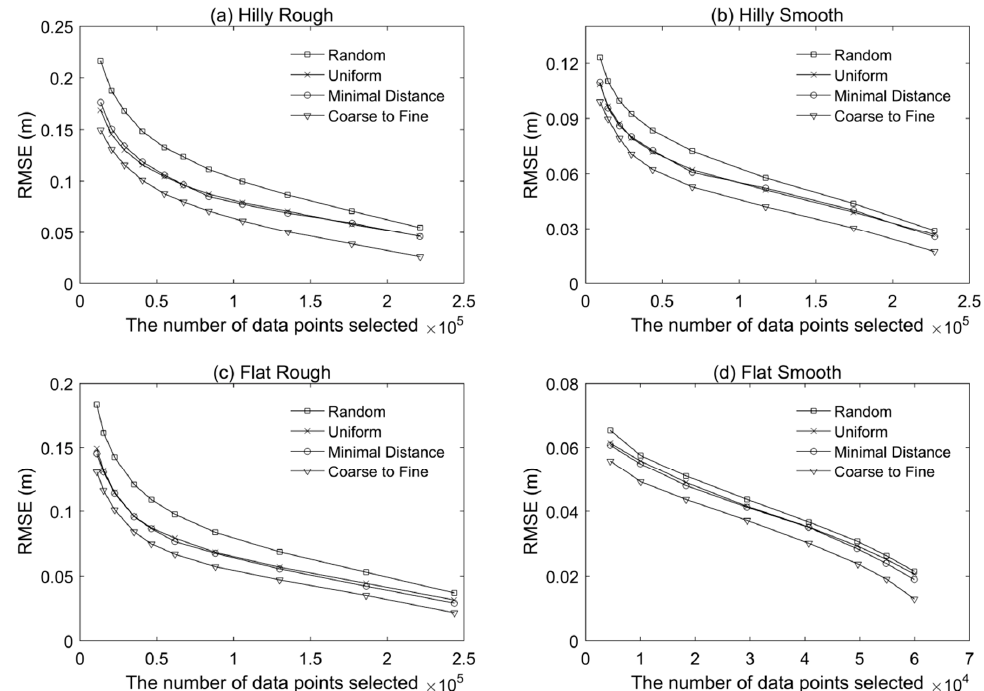
Figure 5. The RMSE versus the number of data points of thinned point clouds for the four terrain surfaces: ( a ) hilly rough, ( b ) hilly smooth, ( c ) flat rough, and ( d ) flat smooth.